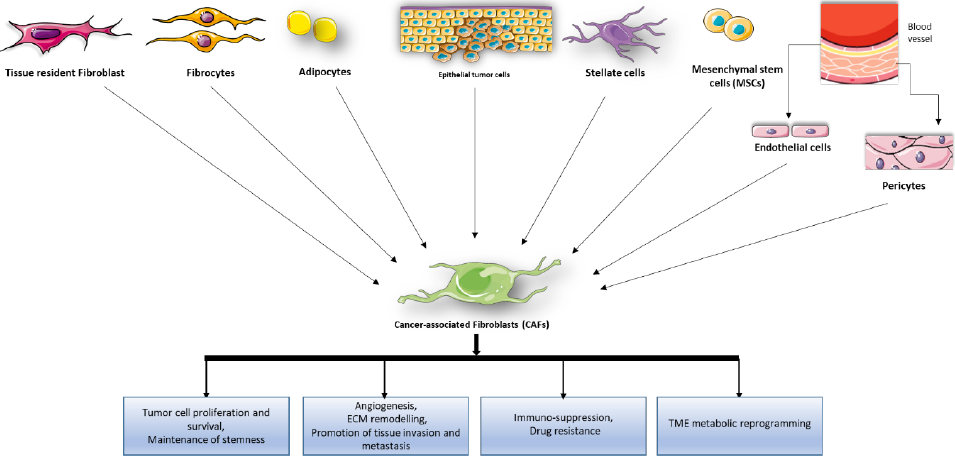
Figure 1. Cancer associated fibroblast (CAF) origins and pro-tumor functions. Potential cellular sources of CAFs include pre-existing resident fibroblasts and stellate cells, epithelial cells, endothelial cells, mesenchymal stem cells, circulating fibrocytes, pericytes, smooth muscle cells, and adipocytes. Activated CAFs exhibit enhanced proliferative and migratory properties and produce components of the extracellular matrix (ECM), growth factors and cytokines promoting ECM remodeling, angiogenesis, tumor cell survival, proliferation, tumor cell stemness maintenance, recruitment of immunosuppressive cells into the TME to assist in immune evasion, drug resistance, and tumor microenvironment (TME) metabolic